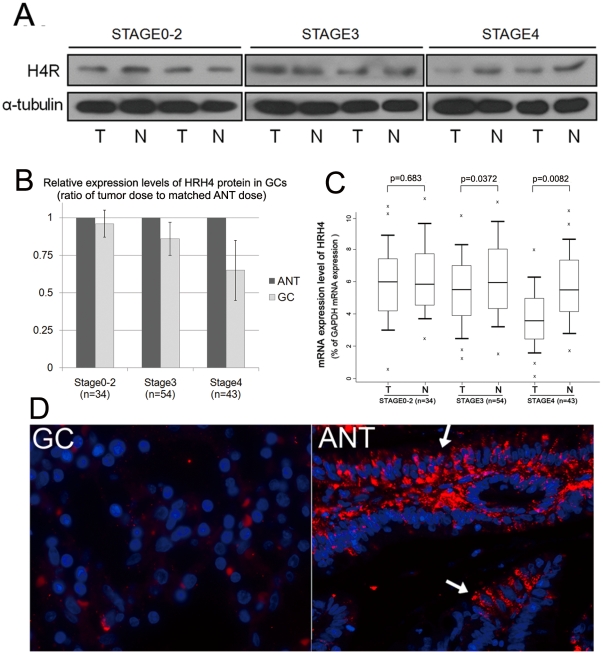
Decreased H4R expression in GCs.(A) Representative blots of HRH4 expression in normal mucosa and gastric tumor tissues. α-tubulin was used as a stable endogenous control. (B) The histogram shows the anlysis of the results from the immunoblottings. The relative expression value of HRH4 protein (normalized by α-tubulin) in GCs is expressed as an average ratio±s.e. of tumor dose to matched adjacent normal tissue dose. *p<0.01 vs. Control, ANT. (C) Real-time PCR assay was carried out as described under Materials and Methods section, boxplots of relative HRH4 mRNA(HRH4/GAPDH) measured with real-time PCR analysis showing median; box: 25th–75th percentile; bars: largest and smallest values within 1.5 box lengths; little cross: outliers. The results were obtained from 3 reactions in each sample. (D) Representative immunofluorescent microscope analysis of paired samples of GC tissue and adjacent normal tissue using anti human HRH4 monoclonal antibody (red). Nuclei were stain with DAPI (blue). Sample I: gastric cancer (GC); sample II: adjacent normal control (ANT). Arrows point to region of positive staining.